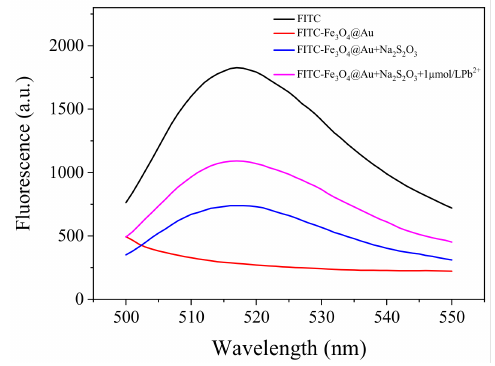
Figure 4. Fluorescence spectra of Fe 3 O 4 @Au–FITC.